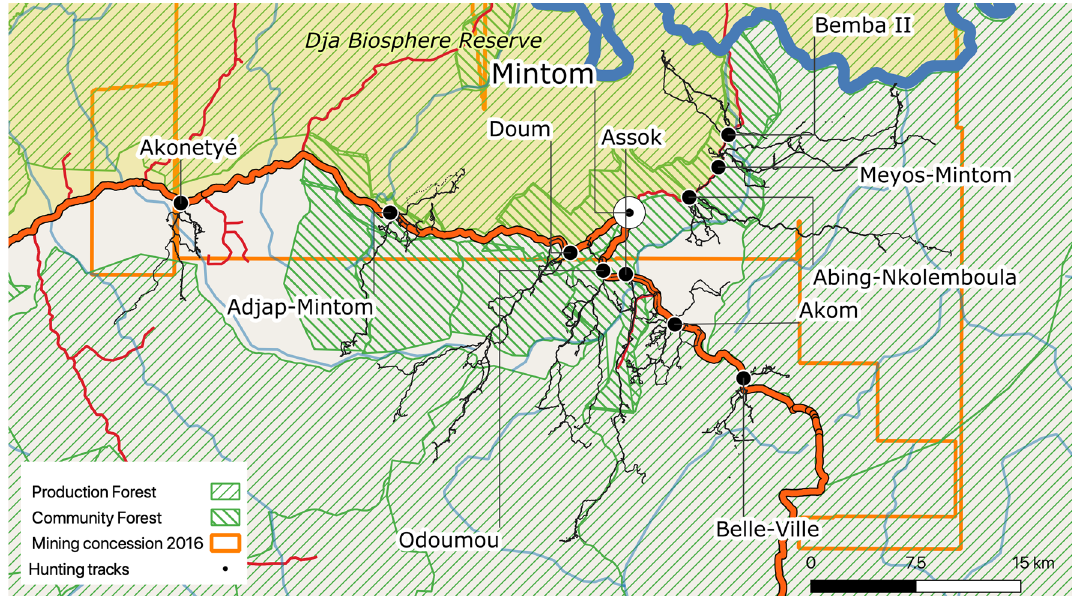
Figure 6. Map of overlap of hunting tracks and logging and mining concessions for the 10 Baka study villages in southeastern Cameroon. The background map was created using QGIS version 3.16.0-Hannover (https ://qgis. org/en/site/) from public domain map datasets from Open Street Map (www.opens treet map.org), diva-gis (diva- gis.org) and Natural Earth (http://www.natur alear thdat a.com) and the published map of the Dja Biosphere Reserve 89